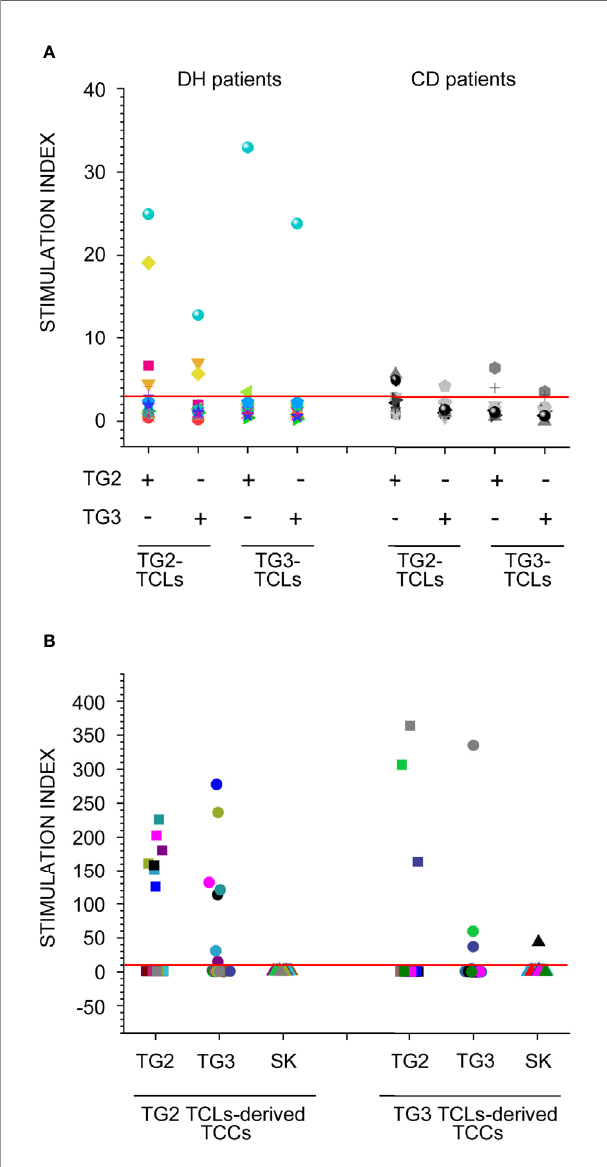
FIGURE 3 | Transglutaminases-speci fi c T cells proliferation assays. (A) Proliferation assay was performed on PB derived TCLs, induced in the presence of TG2 and TG3, from 15 DH patients (left panel) and 12 CD patients (right panel). Each TCLs was stimulated with/without both TG2 and TG3 antigens. Dots with the same shape and colour represent stimulation index (SI) of TCLs derived from the same patients. (B) Proliferation assay was performed on T cell clones (TCCs), derived from antigen speci fi c TCLs from 1 DH patients. Each TCC was stimulated with/without both TG2 and TG3 antigens as well as streptokinase (SK) as negative unrelated control. Dots with the same colour represent SI of the same